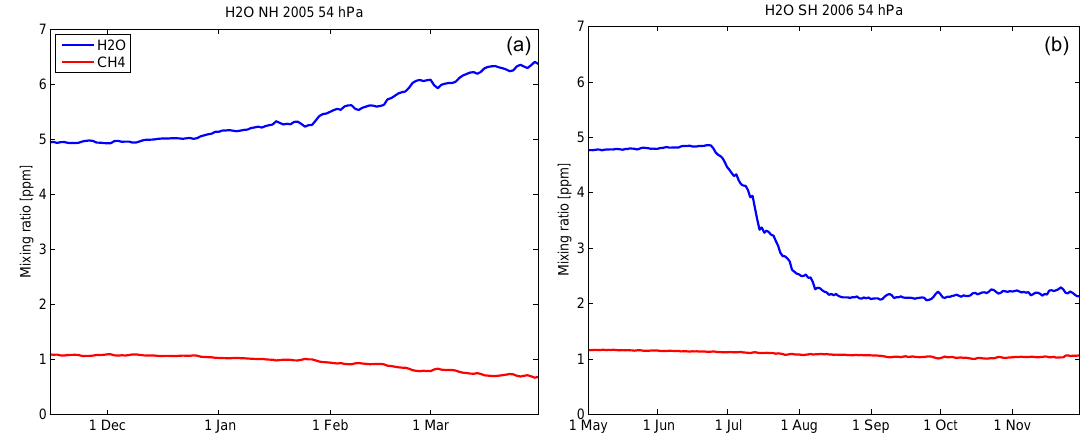
Figure 7. Vortex-averaged mixing ratios of H 2 O and CH 4 for the Arctic winter 2004–2005 and the Antarctic winter 2006 at